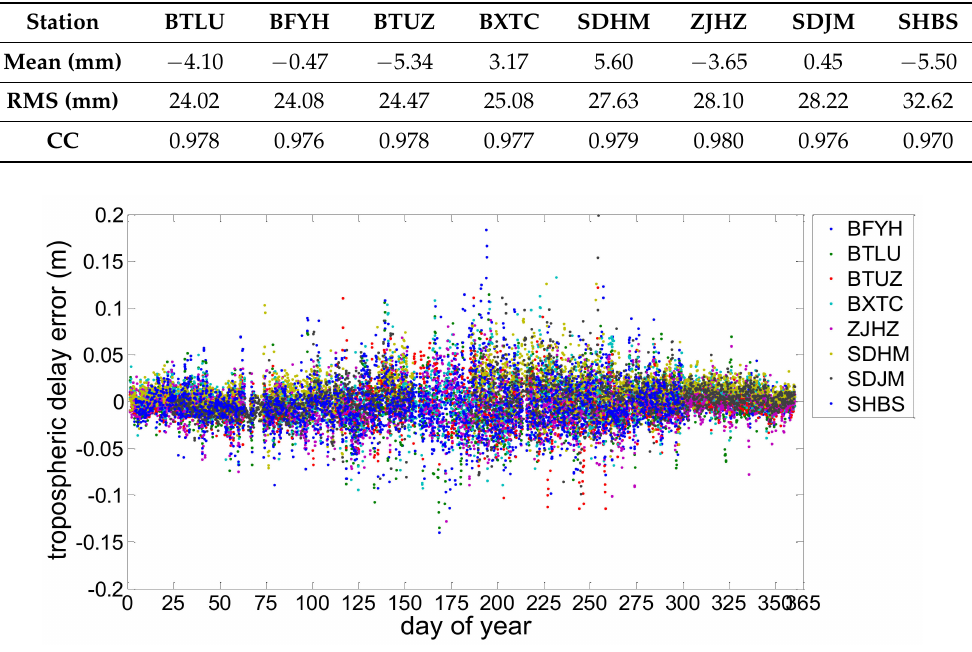
Figure 6. Tropospheric delay residuals of the experimental